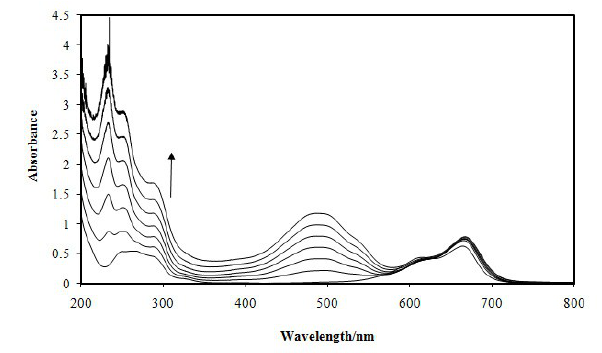
Figure 5. Absorption spectra of the competitive reaction between EPR and MB-DNA. ＝ 0.0, 10.0, 20.0, 30.0, 40.0 and 50.0 μmol L -1 for curves 1-6, C C EPR